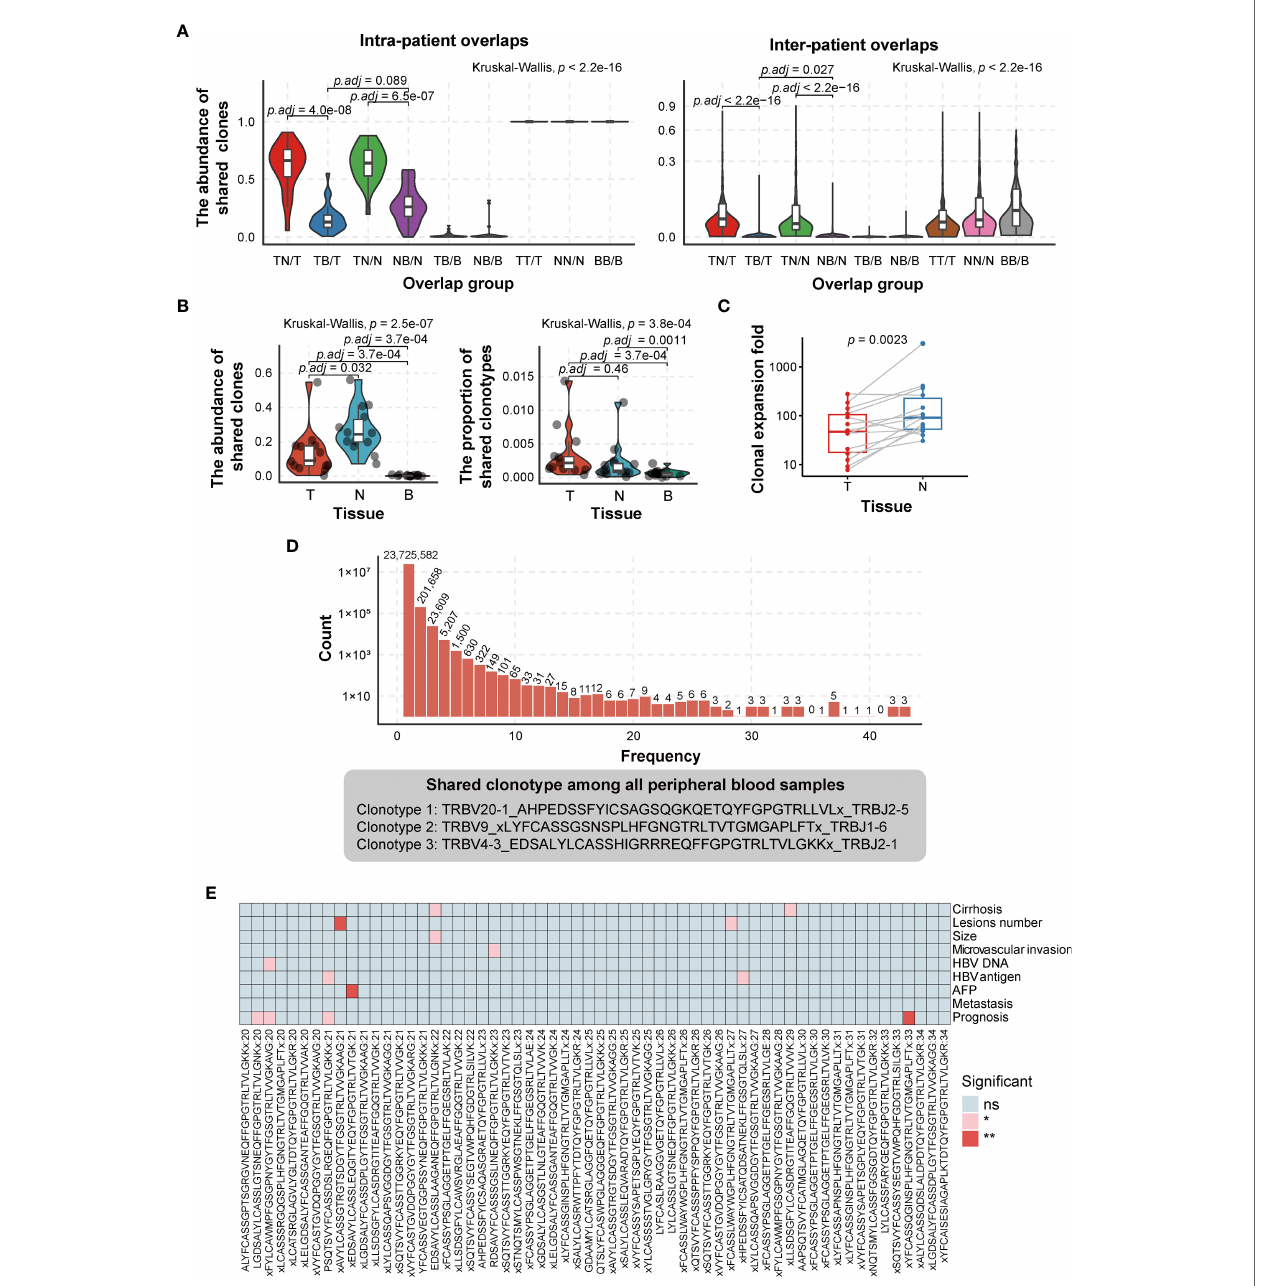
FIGURE 3 | Comparison of TCR b CDR3 heterogeneity in HCC patients. (A) Comparison of the abundance of shared clonotypes overlaps between any two tissues from the same patient (left graph) or between any two patients (right graph). (B) Comparison of the abundance (left graph) and types (right graph) of shared clonotypes among three tissues in a single tissue. T, tumor; N, adjacent non-tumor tissues; B, peripheral blood. TN, the shared clones/clonotypes overlapped between T and N; TB, the shared clones/clonotypes overlapped between T and B; NB, the shared clones/clonotypes overlapped between N and B; TNB, the shared clones/clonotypes overlapped among T, N, and B. p -Values are shown in panels A and B according to Kruskal – Wallis (for multiple groups ’ comparison) and Wilcoxon test (for two groups ’ comparison). p -Value adjusted by Bonferroni correction. (C) The degree of clonal expansion in adjacent non-tumor tissues, which was calculated on the basis of the ratio of the proportion of TNB shared clones in T/N to in B. It represents the clonal expansion rate of “ TNB shared clones ” in T/N compared to B. T, tumor; N, adjacent non-tumor tissues; B, peripheral blood. TNB, the shared clones overlapped among T, N, and B. p -Values are shown in panel C according to paired Wilcoxon test. (D) The distribution of shared CDR3 clonotypes in peripheral blood samples (top) and shared clonotypes among all 43 peripheral blood samples (bottom). (E) The association of the clonotypes, which are present in 20 – 34 (47% – 80% in 43 samples) peripheral blood samples and patient clinical phenotype (considering the sample size of “ without group, ” the clonotypes, which are present in no more than 34 peripheral blood samples, are selected). ns, no signi fi cance, p > 0.05; * p < 0.05; ** p < 0.01. TCR, T-cell receptor; HCC, hepatocellular